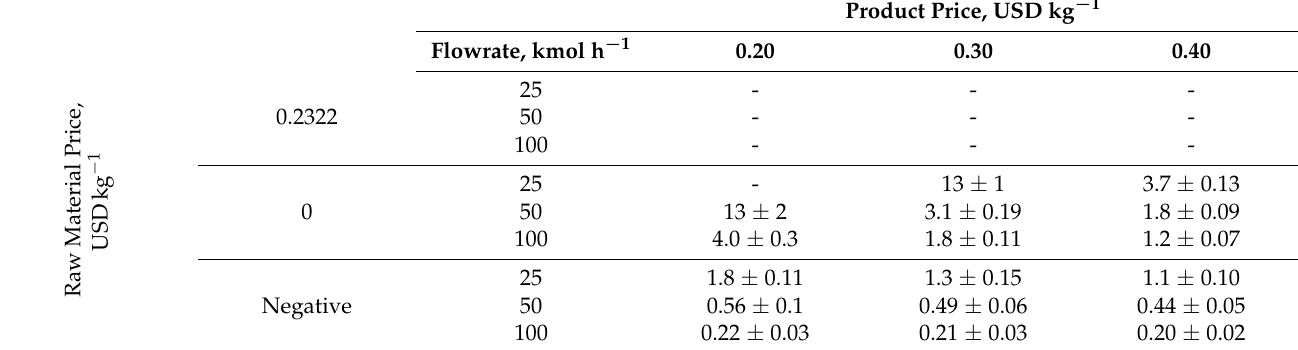
Table 6. If associated gas costs the same as natural gas, the MRU is uneconomical at all scales studied. In other cases, the higher the quantity of natural gas treated, the lower the payback time. Results are expressed as the average of 3000 simulations ± 1 σ